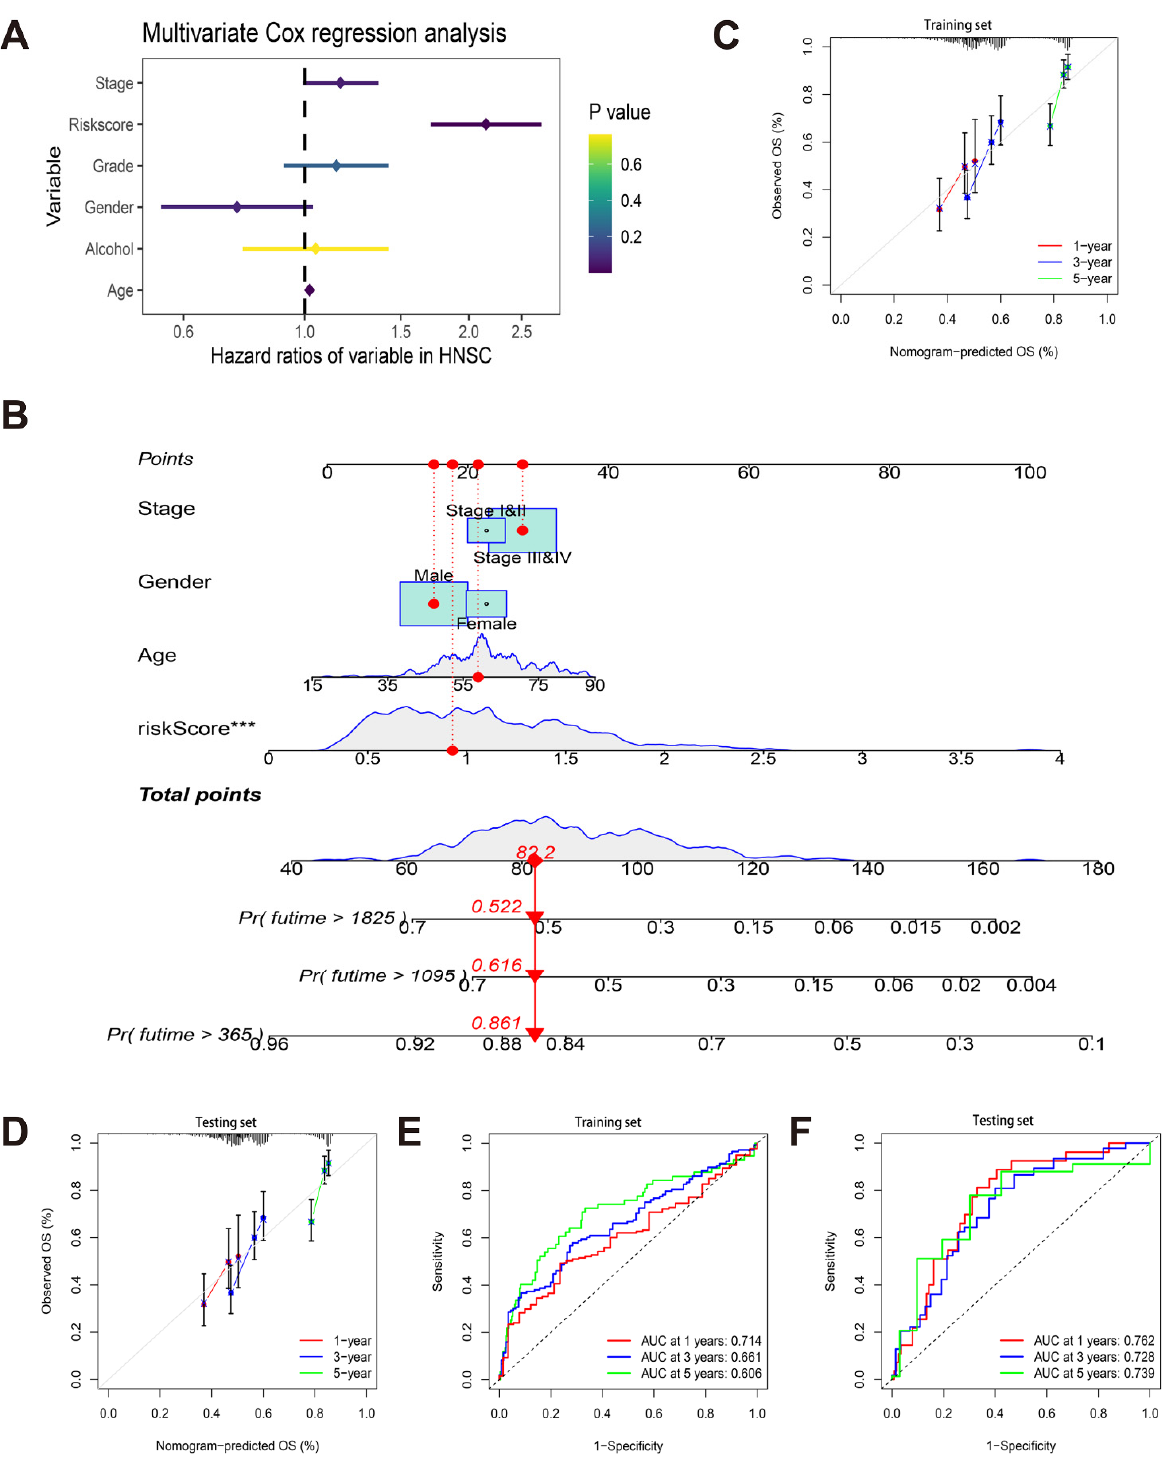
Figure 3. Construction and verification of a nomogram. ( A ) Forest plots of multivariate Cox regression analysis involving the risk score and clinical parameters; ( B ) prognostic nomogram for predicting OS of HNSCC patients based on TCGA training set; ( C , D ) the nomogram calibration curves for predicting OS at the time point of 1, 3, and 5 years in the training set ( C ) and testing set ( D ); ( E , F ) the ROC curves and AUC values of the nomogram for 1-, 3-, and 5-year OS in the training set ( E ) and testing set ( F ). (*** p < 0.001, The p value of multivariate Cox regression analysis of all indicators included in the